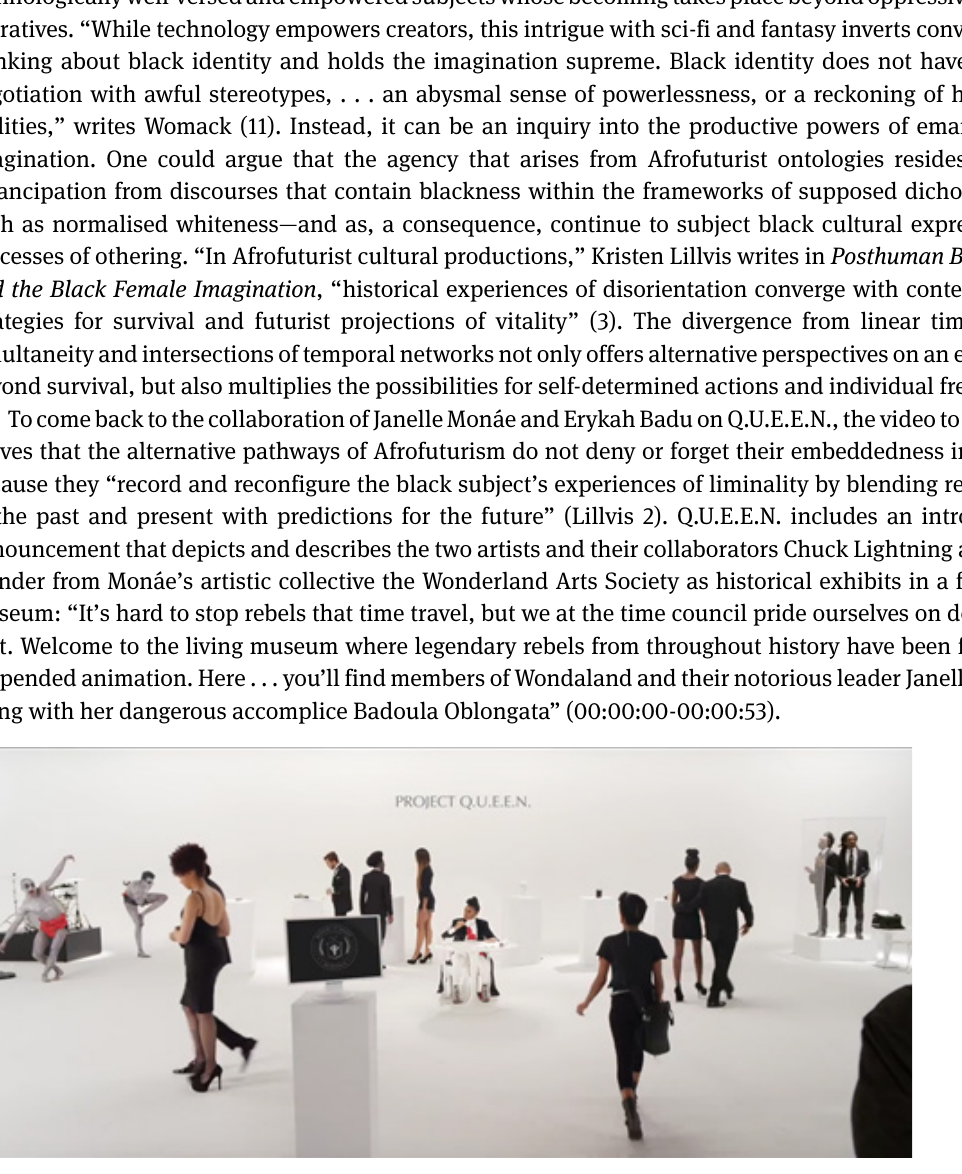
Figure 1. Still from the music video showing Janelle Monáe and Wondaland members with visitors walking through the exhibi- tion (“Q.U.E.E.N”